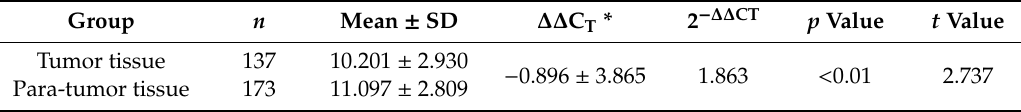
Table 1. Relative expression of miR-21-3p in esophageal cancer tissues and matched para-cancer tissues. Group n Mean ± SD ∆∆ C T * 2 − ∆∆ CT p Value t Value Tumor tissue 137 10.201 ± 2.930